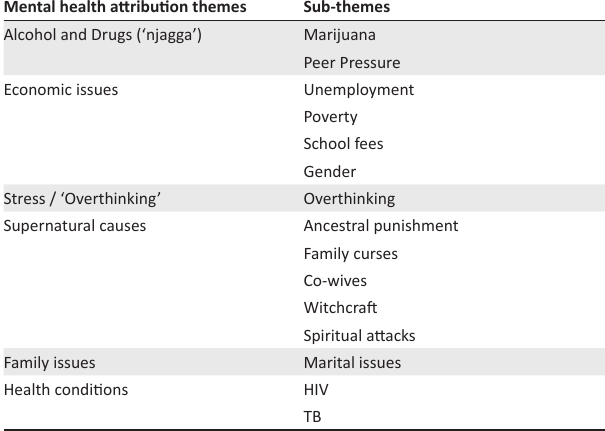
TABLE 2: Mental health attribution discussion themes.